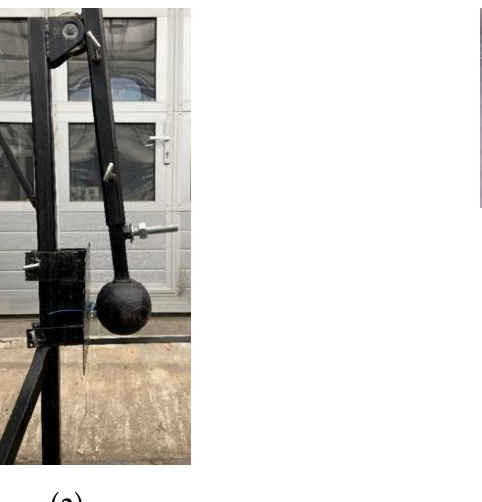
8 of 15 Figure 7. Load-displacement curve for FE model and experimental specimen. After validating the individual material models of the battery components and estab- lishing the jelly roll proprieties, the next step was the explicit dynamic simulation of a battery cell under impact. 3. Impact Testing and Simulation 3.1. Experimental Setup The experimental setup consisted of a gravitational pendulum with a 9 kg ball and 60 mm radius hitting the battery fixed on a metal plate (Figure 8). The pendulum arm was 620 mm long and the dropping angle was 83°. The whole system had a relatively little movement when the impact was produced, so a small error in the results was expected.